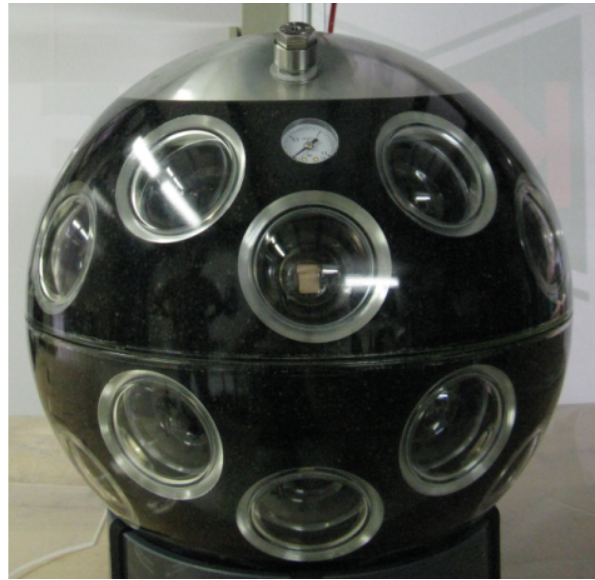
Fig. 6. Multi-PMT optical module, containing 31 PMTs with 3” diameter photocathode in a large glass sphere.